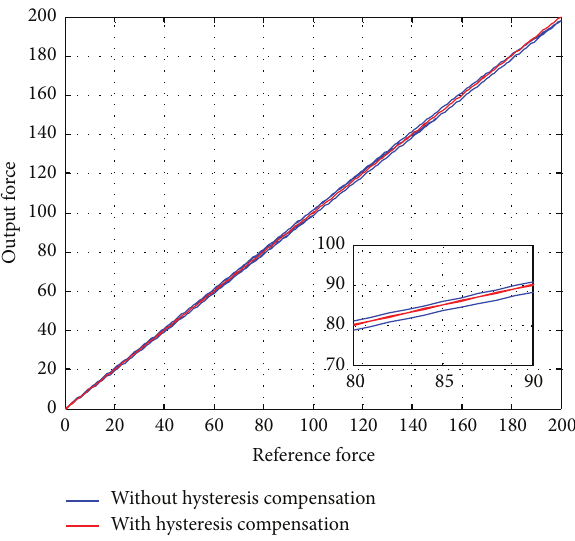
Figure 8: Comparison of the force hysteresis loop between force generations without hysteresis compensation and with hysteresis compensation.